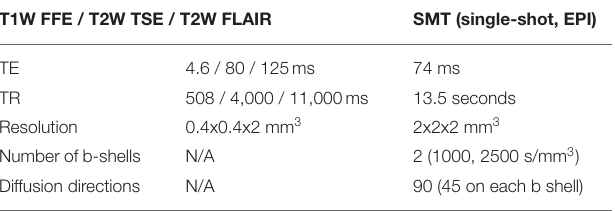
TABLE 2 | Multi-slice multi-shell diffusion-weighted imaging